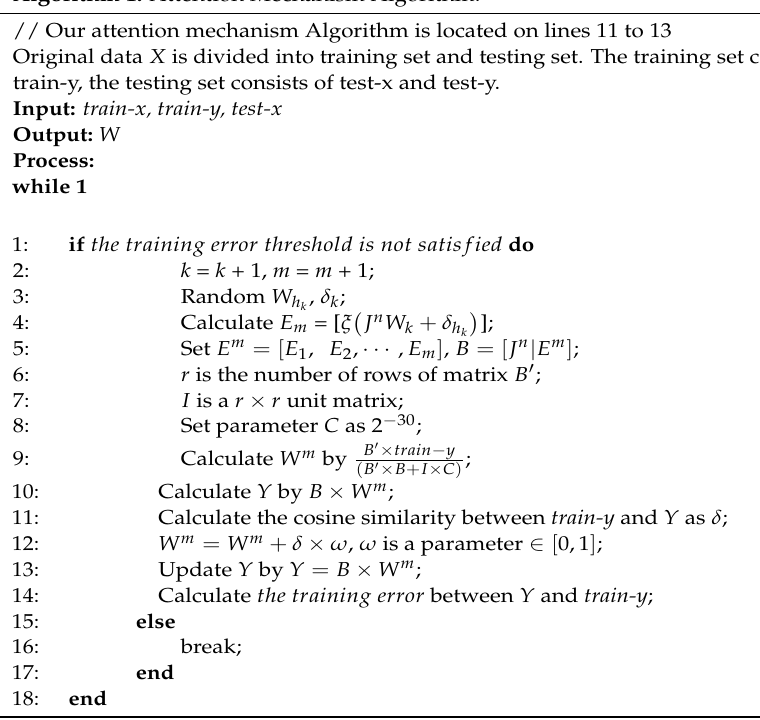
Algorithm 1: Attention Mechanism